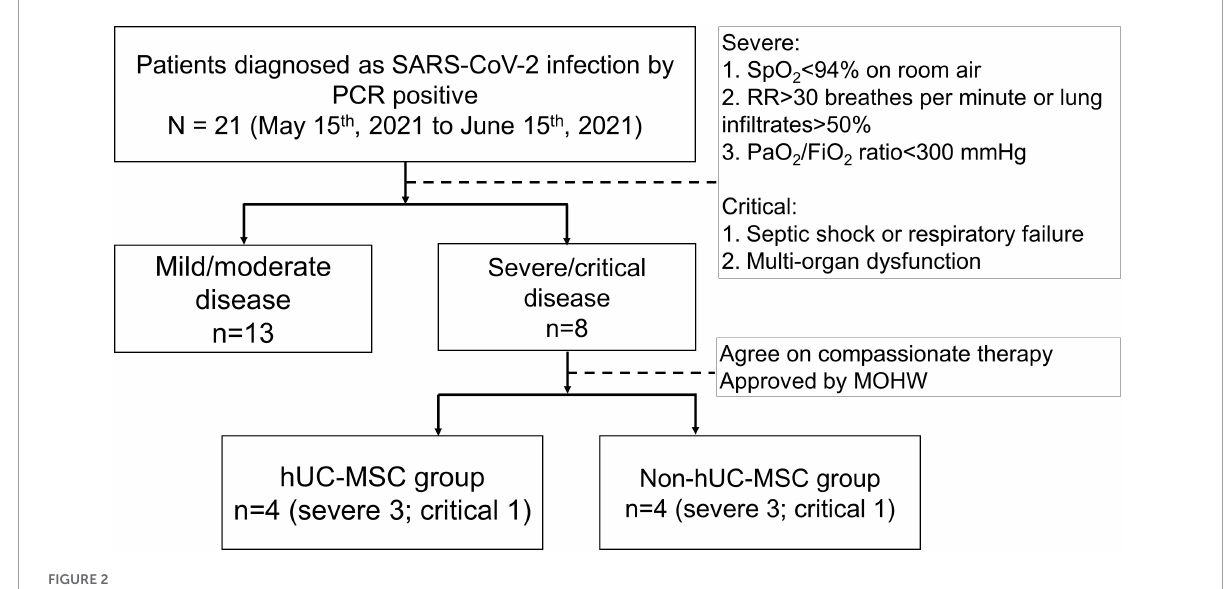
FIGURE2 The flow diaphragm of the study. Hospitalized patients who were diagnosed with 2019 novel coronavirus disease (COVID-19) by a positive real-time polymerase chain reaction (RT-PCR) for SARS-CoV-2 from nasal swab specimens were enrolled in this retrospective case control study between May 15, 2021, and June 15, 2021. The disease severity of COVID-19 affected patients was classified as mild, moderate, severe and critical conditions according to the National Institutes of Health treatment guidelines. A total of 21 patients with RT-PCR-confirmed SARS-CoV-2 infection were enrolled, of whom 13 patients were classified as having a mild/moderate disease and 8 as a severe/critical disease. Patients with severe/critical disease were separated into hUC-MSC and non-hUC-MSC groups. SARS-CoV-2, severe acute respiratory syndrome coronavirus 2; PCR, polymerase chain reaction; SpO 2 , oxyhemoglobin saturation by pulse oximetry; RR, respiratory rate; PaO 2 /FiO 2 ratio, arterial partial pressure of oxygen to fraction of inspired oxygen ratio; MOHW, Ministry of Health and Welfare; hUC-MSC, human umbilical cord mesenchymal stem